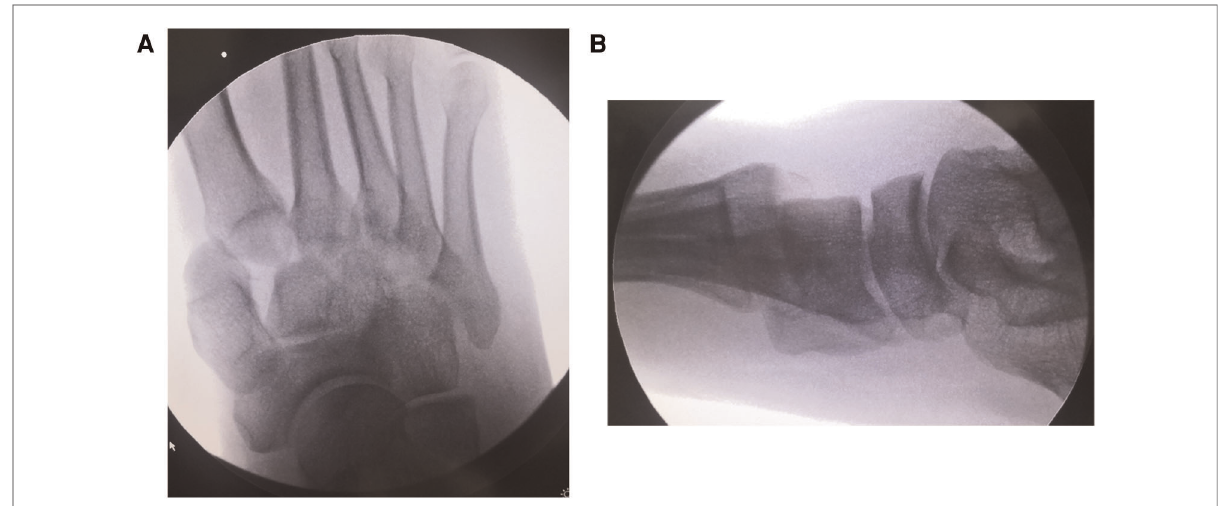
FIGURE 1 Anteroposterior and lateral radiographs of the patient ’ s injured foot on admission, showing complete dislocation of the metatarsophalangeal joint. ( A ) Anteroposterior ( B )